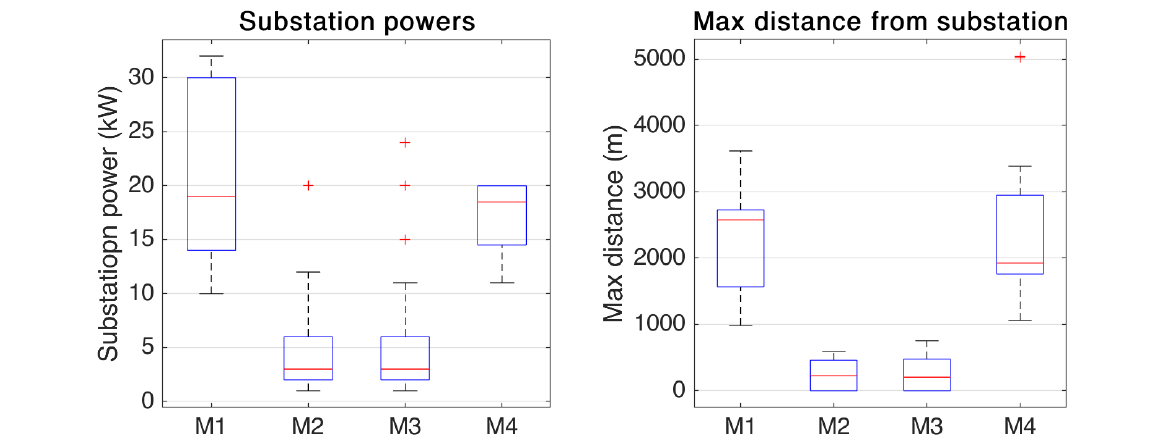
Figure 5. Omereque-Power and max distance